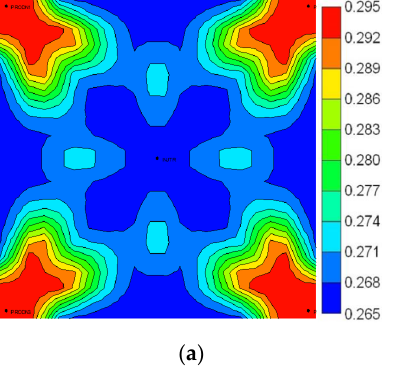
Figure 16. Physical property distribution in 5-spot well pattern after steam flooding. ( a ) Porosity distribution; ( b ) permeability